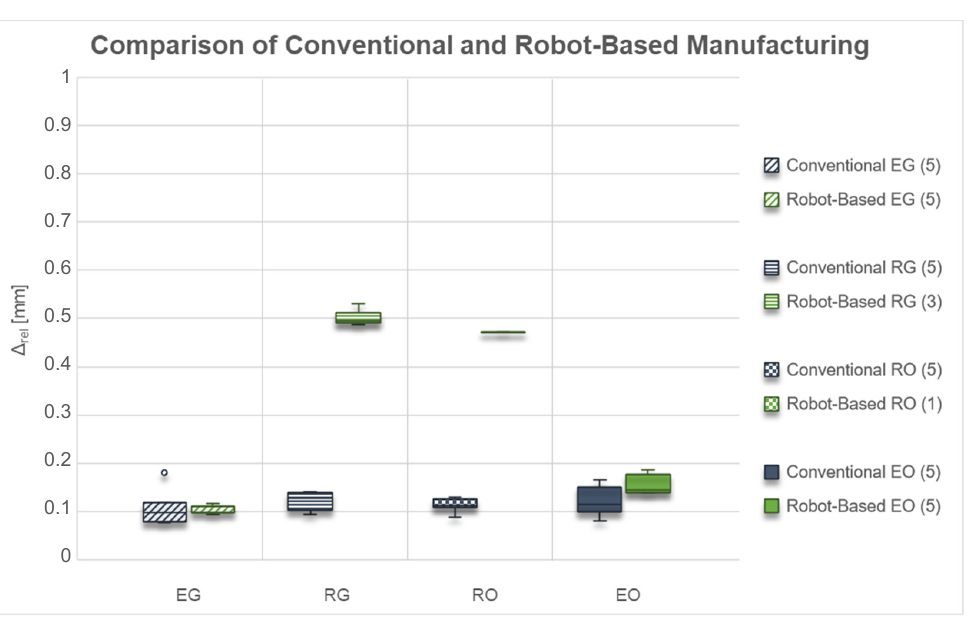
Figure 7. Box Plots of shape deviations by conventional and robotic fused filament fabrication on silicone build plates (included number of samples).